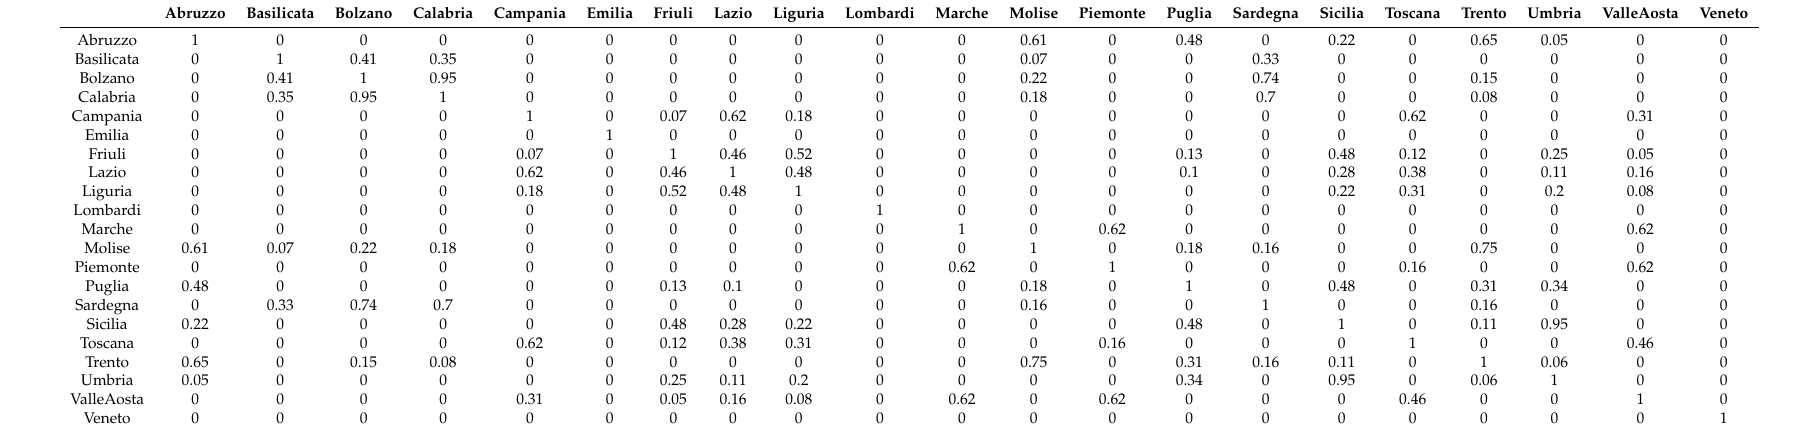
Table A27. Similarity values of Total Currently Positive network in the second week.